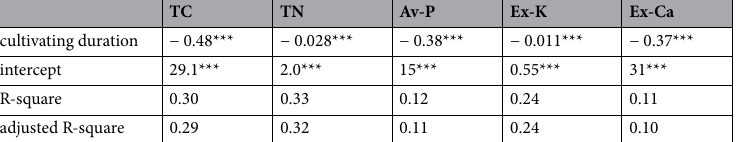
Table 3. Results of the regression analysis to estimate the effect of maize cultivating duration on five soil properties in sloped fields. ***Represents statistical significance at p <